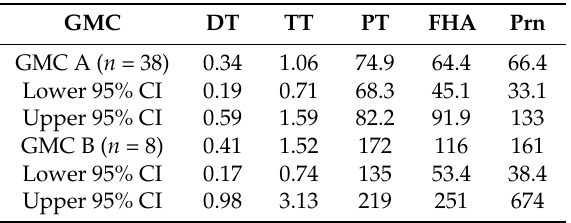
Table 4. Geometric mean concentrations of anti-DT, anti-TT, anti-PT, anti-FHA and anti-Prn concentrations in subjects with anti-PT levels between 50 and 125 IU/mL (GMC A) and in subjects with anti-PT levels >125 IU/mL (GMC